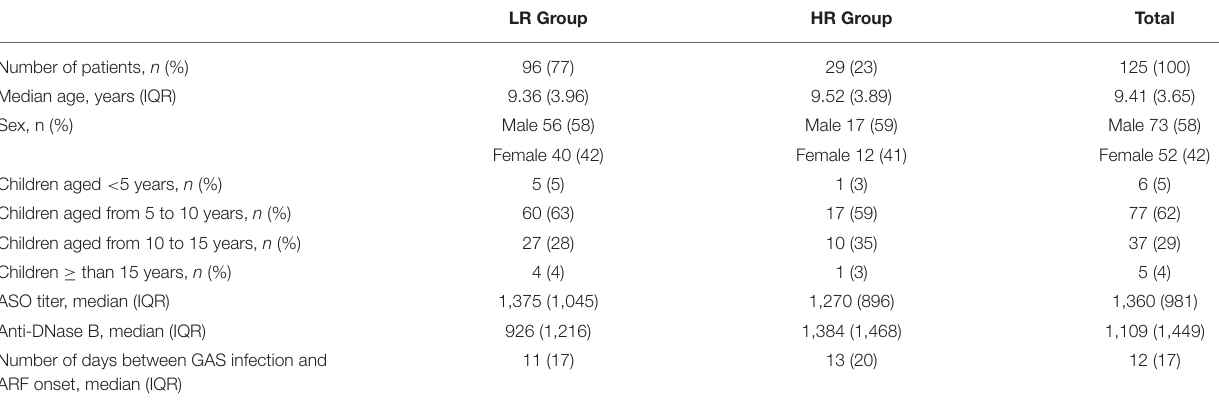
LR Group HR Group